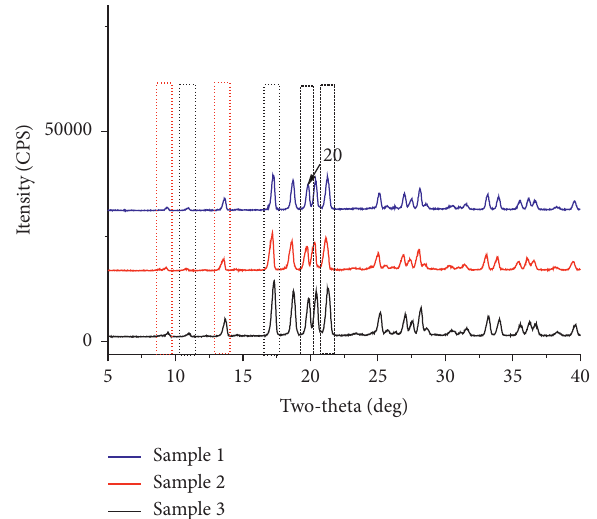
Figure 9: X-ray diffraction patterns of three groups of